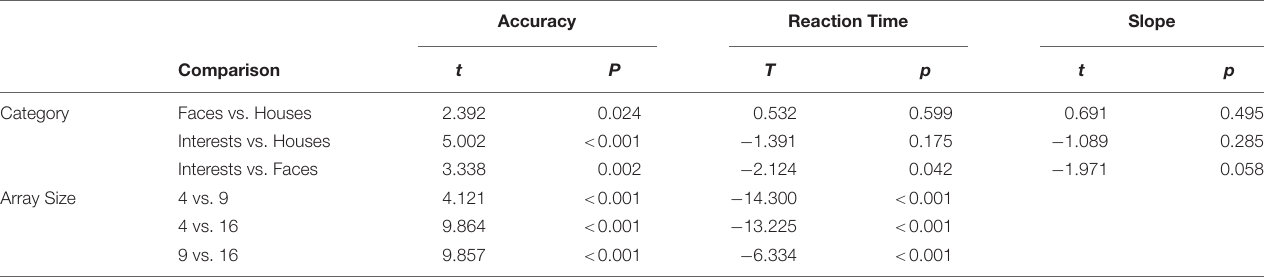
TABLE 3B | Exemplar task statistics ( Post hoc analyses).